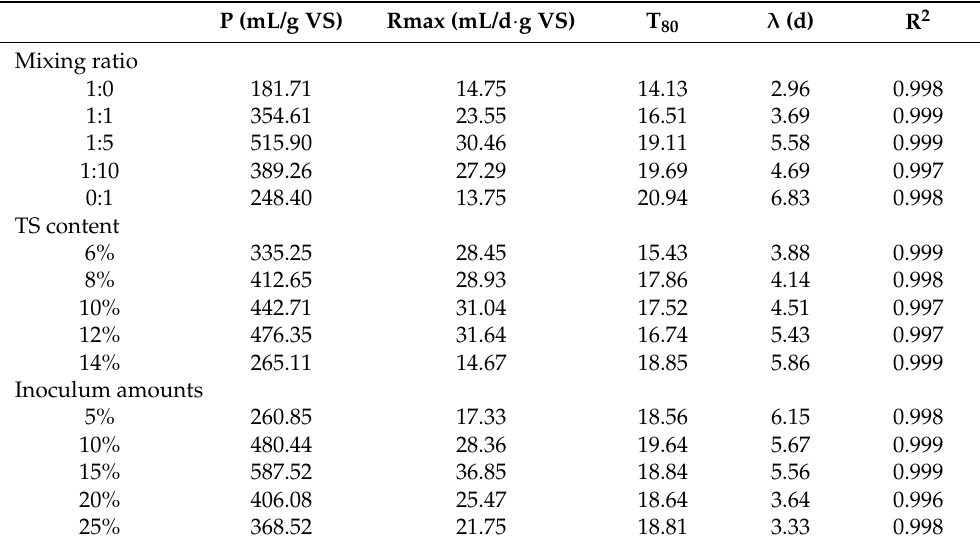
Figure 5. The results of Gompertz model analysis of the potential methane production under different mixing ratios ( a ), TS concentrations ( b ), and inoculum amounts ( c ). Table 2. The kinetic parameters estimated at the different conditions.